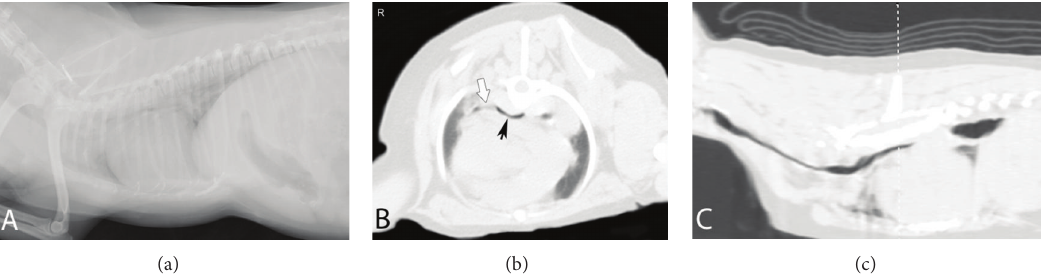
Figure 1: Preinterventional radiographic (a) overview of the thorax, left lateral projection. The thoracic volume is small and the caudoventral rib cartilages are pulled inwards. Pulmonary contrast is poor. The tracheal and mainstem bronchial lumen are partly reduced in width and opacified. Computed tomography (CT) was performed 12h later, transverse view (b) at the level of the bifurcation (reference line) in the sagittal reconstruction (c). The scan performed without intubation is shown here. Severe dorsoventral tracheal flattening (black arrowhead) is present, and the right mainstem bronchus (solid white arrow) is also